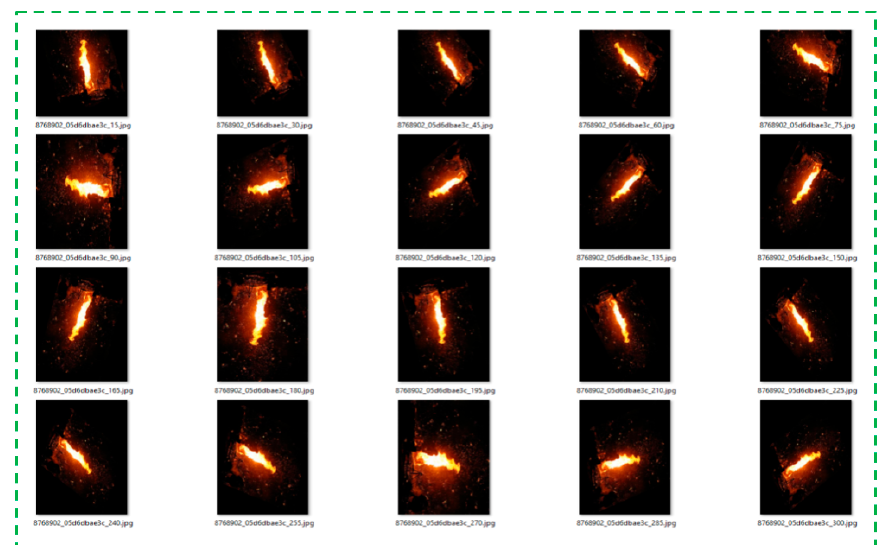
Figure 1. Example images of forest fire rotation from different angles. Table 2. Distribution of fire and non-fire images in the dataset.